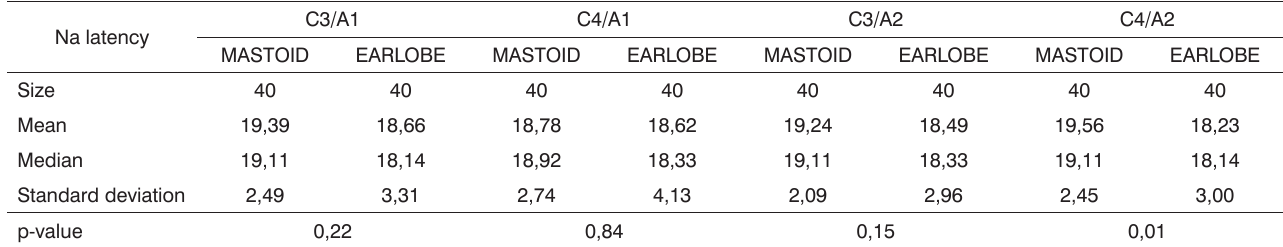
Table 3. Comparing the Na wave latencies in MLEAP C3/A1, C4/A1, C3/A2, C4/A2 modes between the mastoid and earlobe.